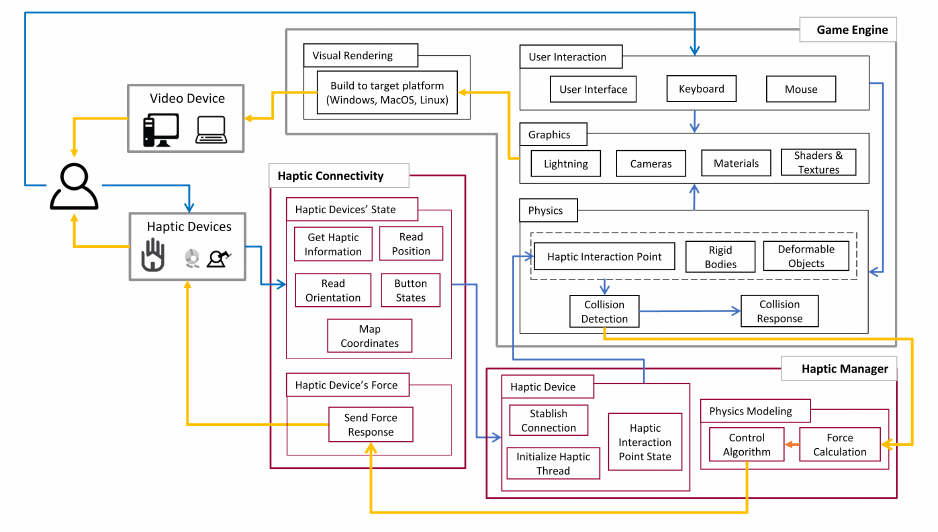
Figure 3. Proposed architecture for haptic devices integration in game